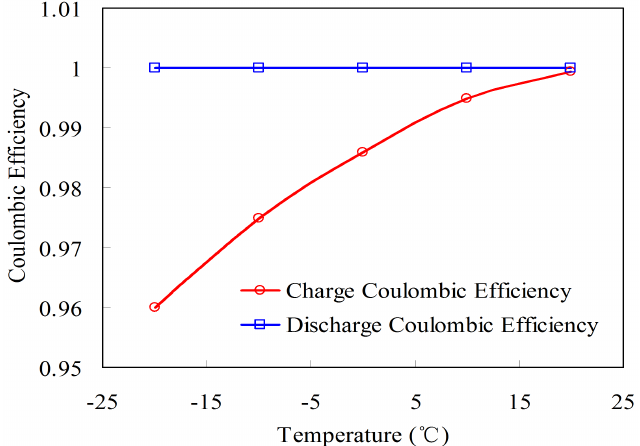
η at different , I T